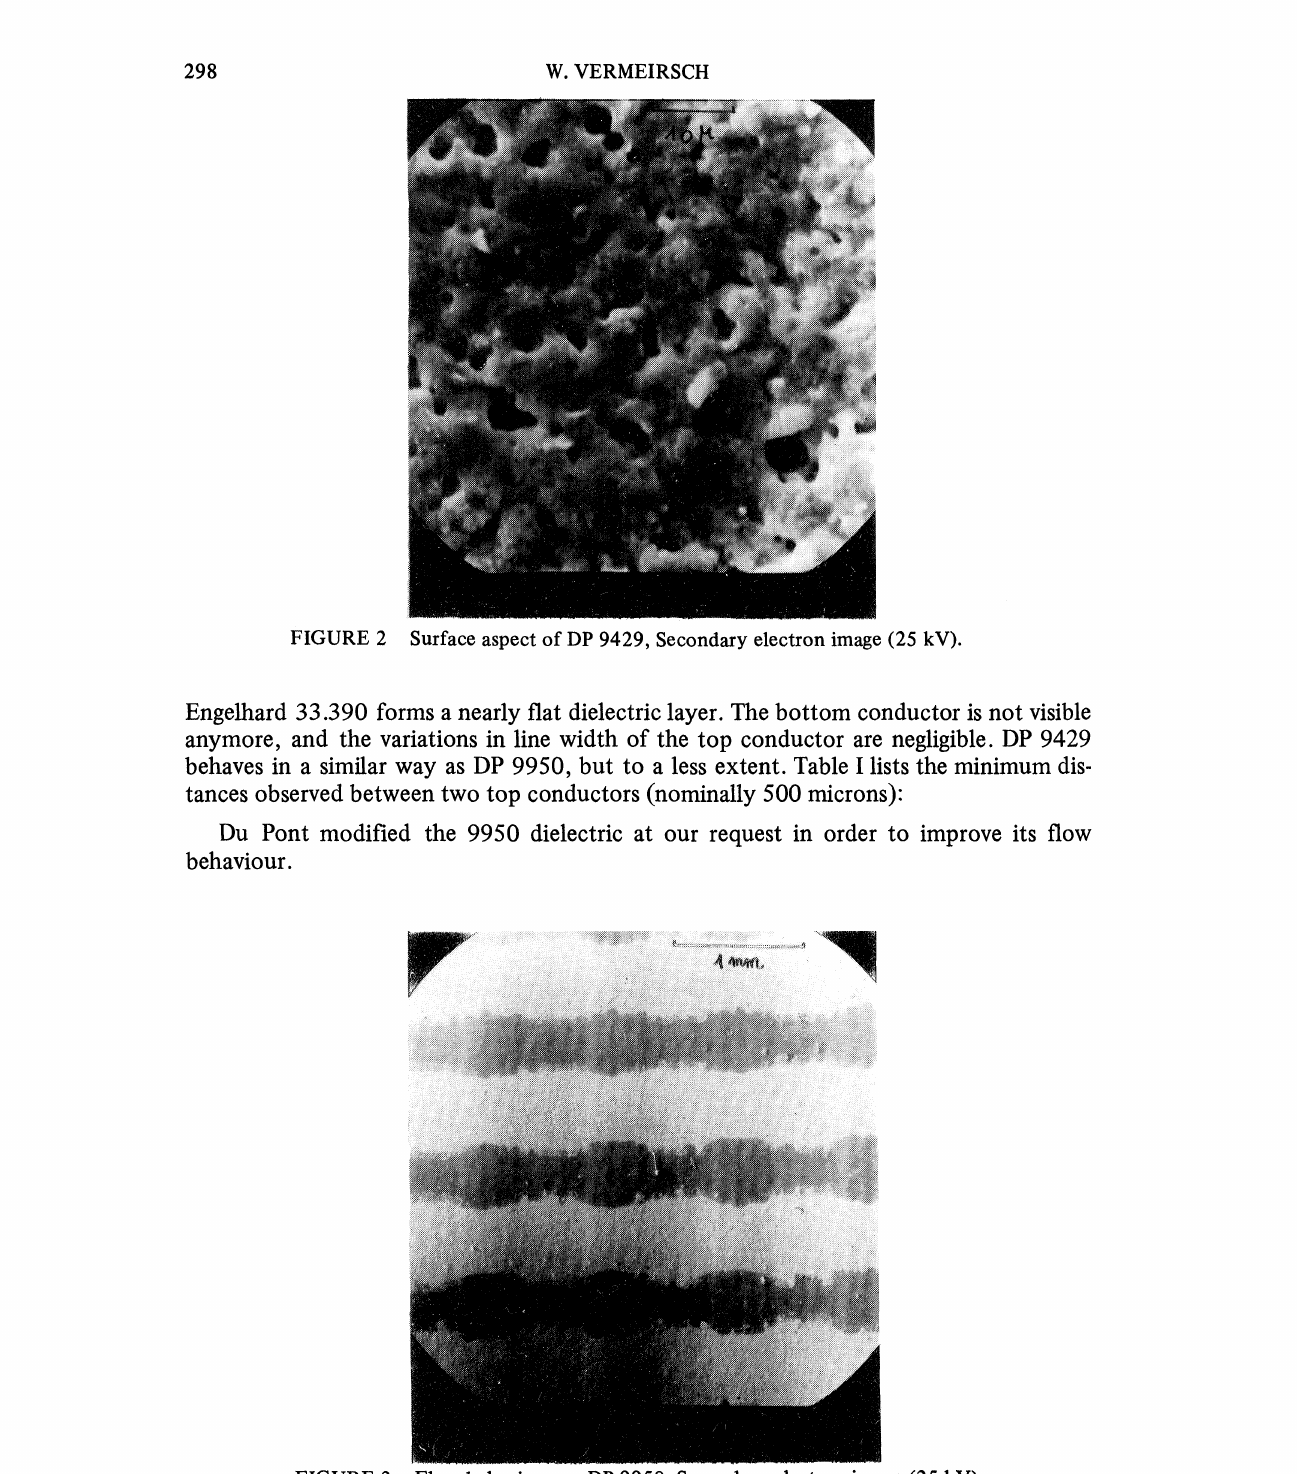
FIGURE 3 Flow behaviour on DP 9950, Secondary electron image (25